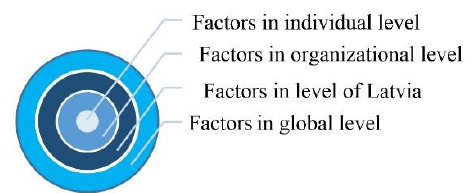
Fig. 5. Web-based IMS influencing factor model (the model created by the authors based on CSR in Action (2008)). The main factors are summarised in Table